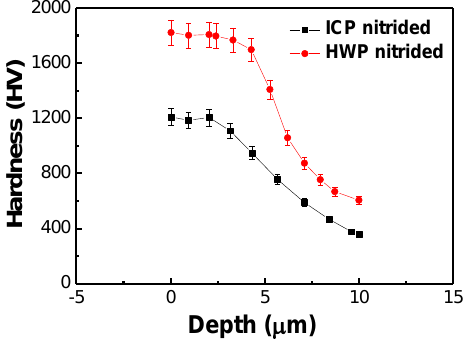
Figure 6. Microhardness profiles of Samples S2 and S3.